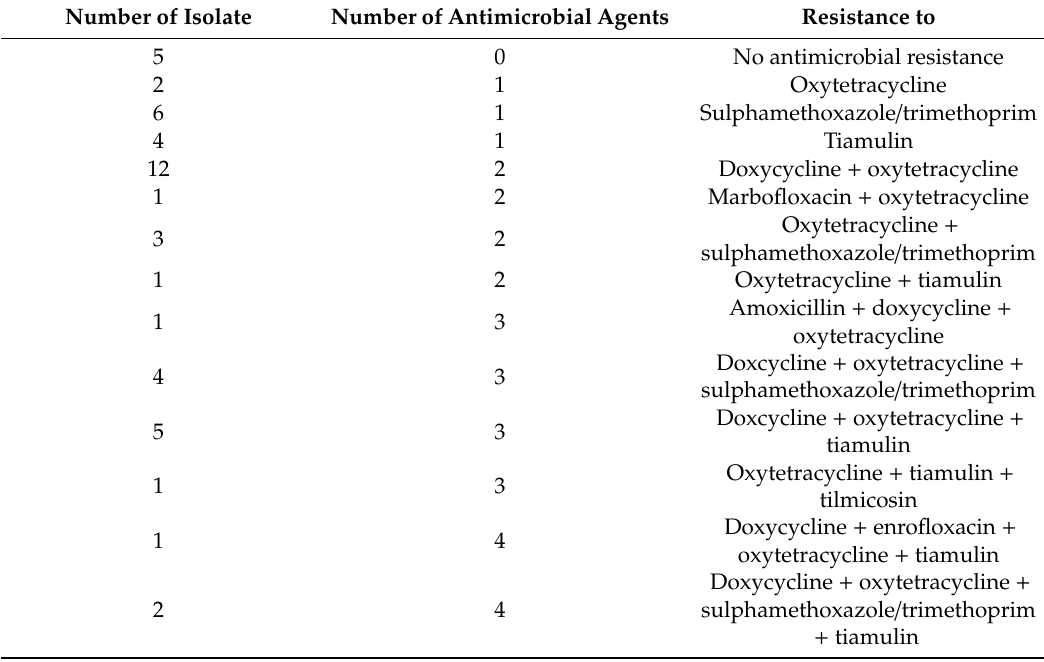
Table 2. Antimicrobial resistance profiles of 48 Pasteurella multocida strains in this